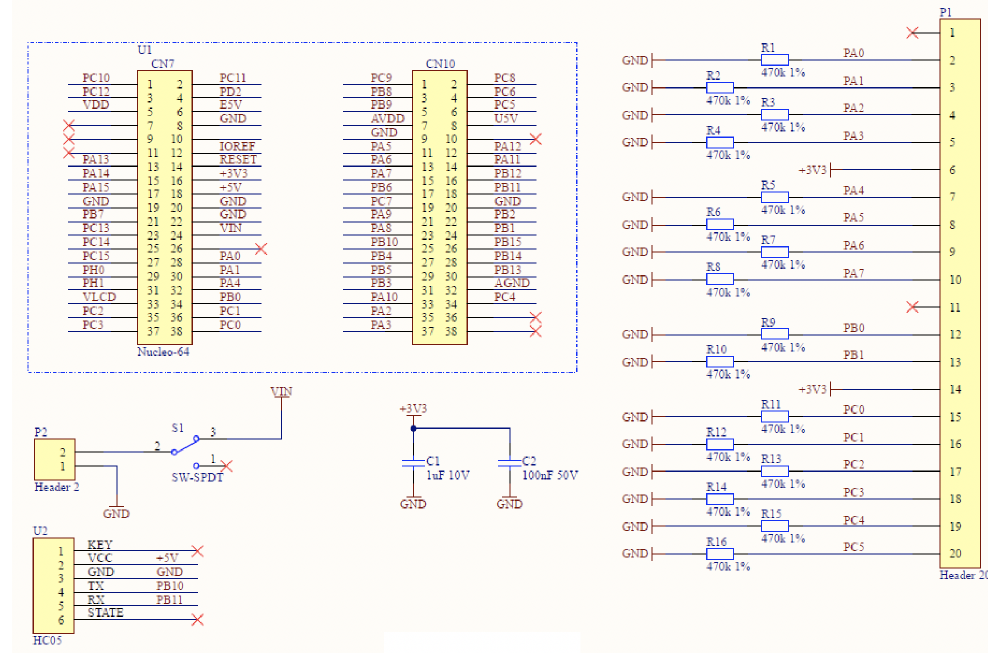
Figure 6. Dedicated PCB